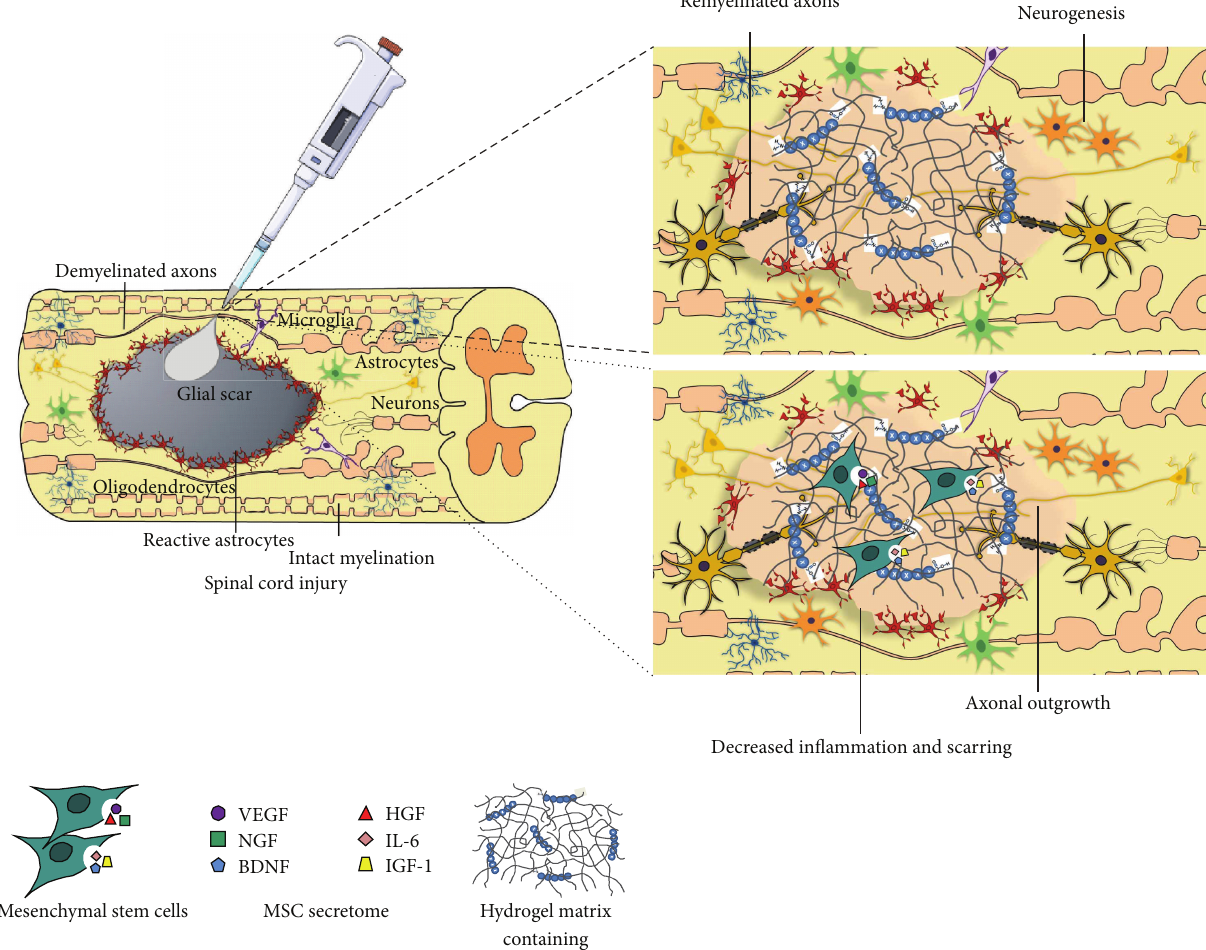
Figure2:Theuseofhydrogelmatricesortheircombinationwithcelltherapy,suchasMSCtransplantation,forSCItreatmentmightpotentiate axonal regeneration and outgrowth through the injury